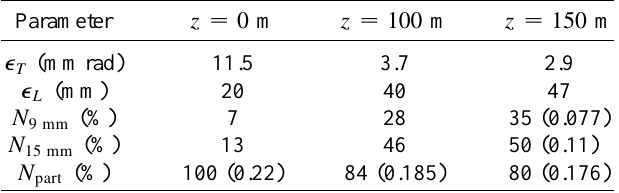
TABLE IV. Evolution of beam parameters in the single flip cooling channel. The number of muons per proton incident on target is shown in parentheses in the last three